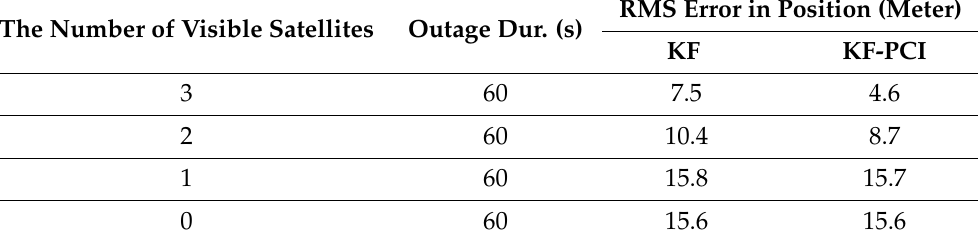
Table 3. RMS horizontal position error over all partial GNSS outages. The Number of Visible